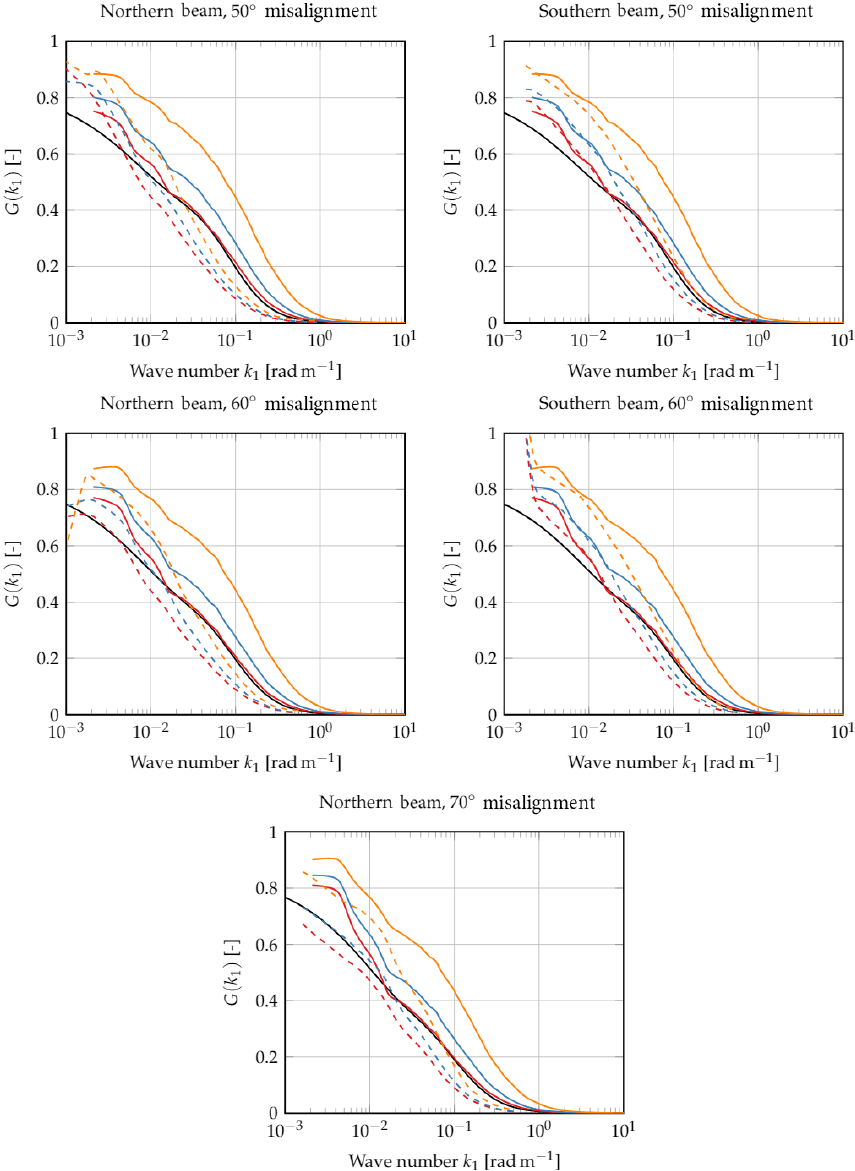
Figure A1. Transfer function G(k 1 ) for the remaining misalignment